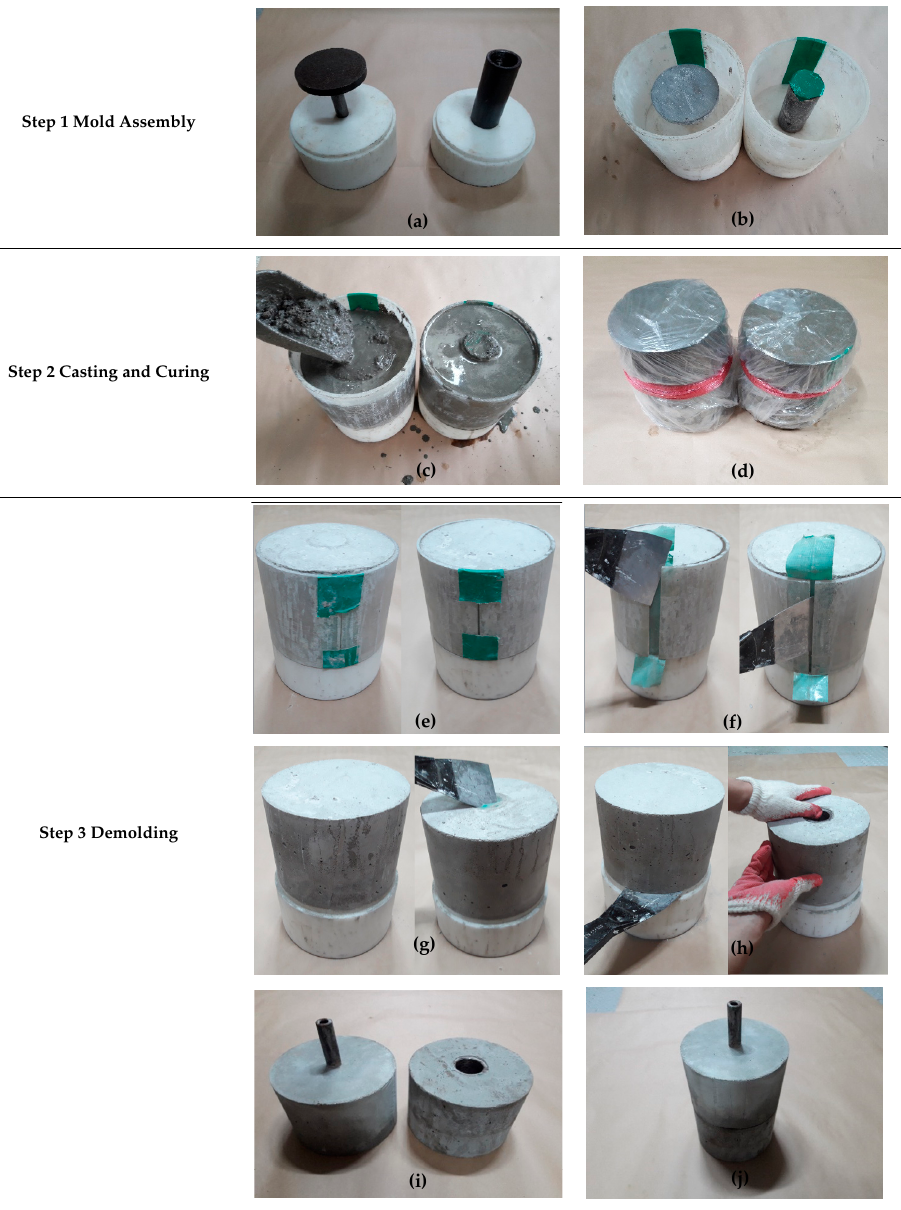
Table 10. Procedure for mortar specimen preparation.